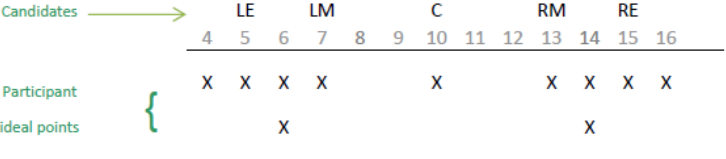
Figure 1. Voters’ ideal points and candidates’